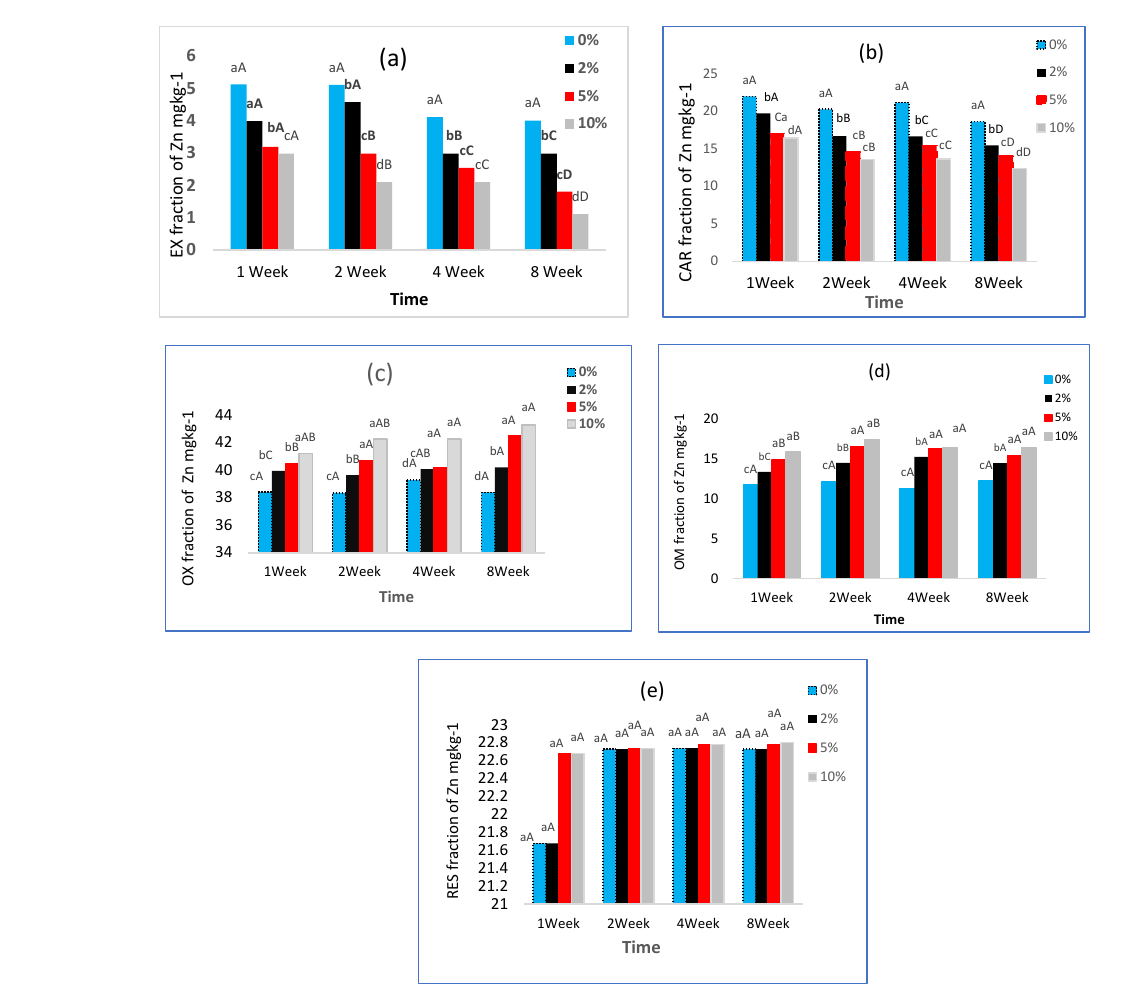
Figure 5. (a) Exchangeable (EX) fraction, (b) Carbonate (CAR) fraction, (c) Oxides (OX) fraction, (d) Organic Matter (OM) fraction and (e) Residual (RES) fraction. Small letters indicate the effect of different Conocarpus Waste (CW) biochar rates on chemical forms on Cu, and capital letters indicate the effect of biochar on different incubation